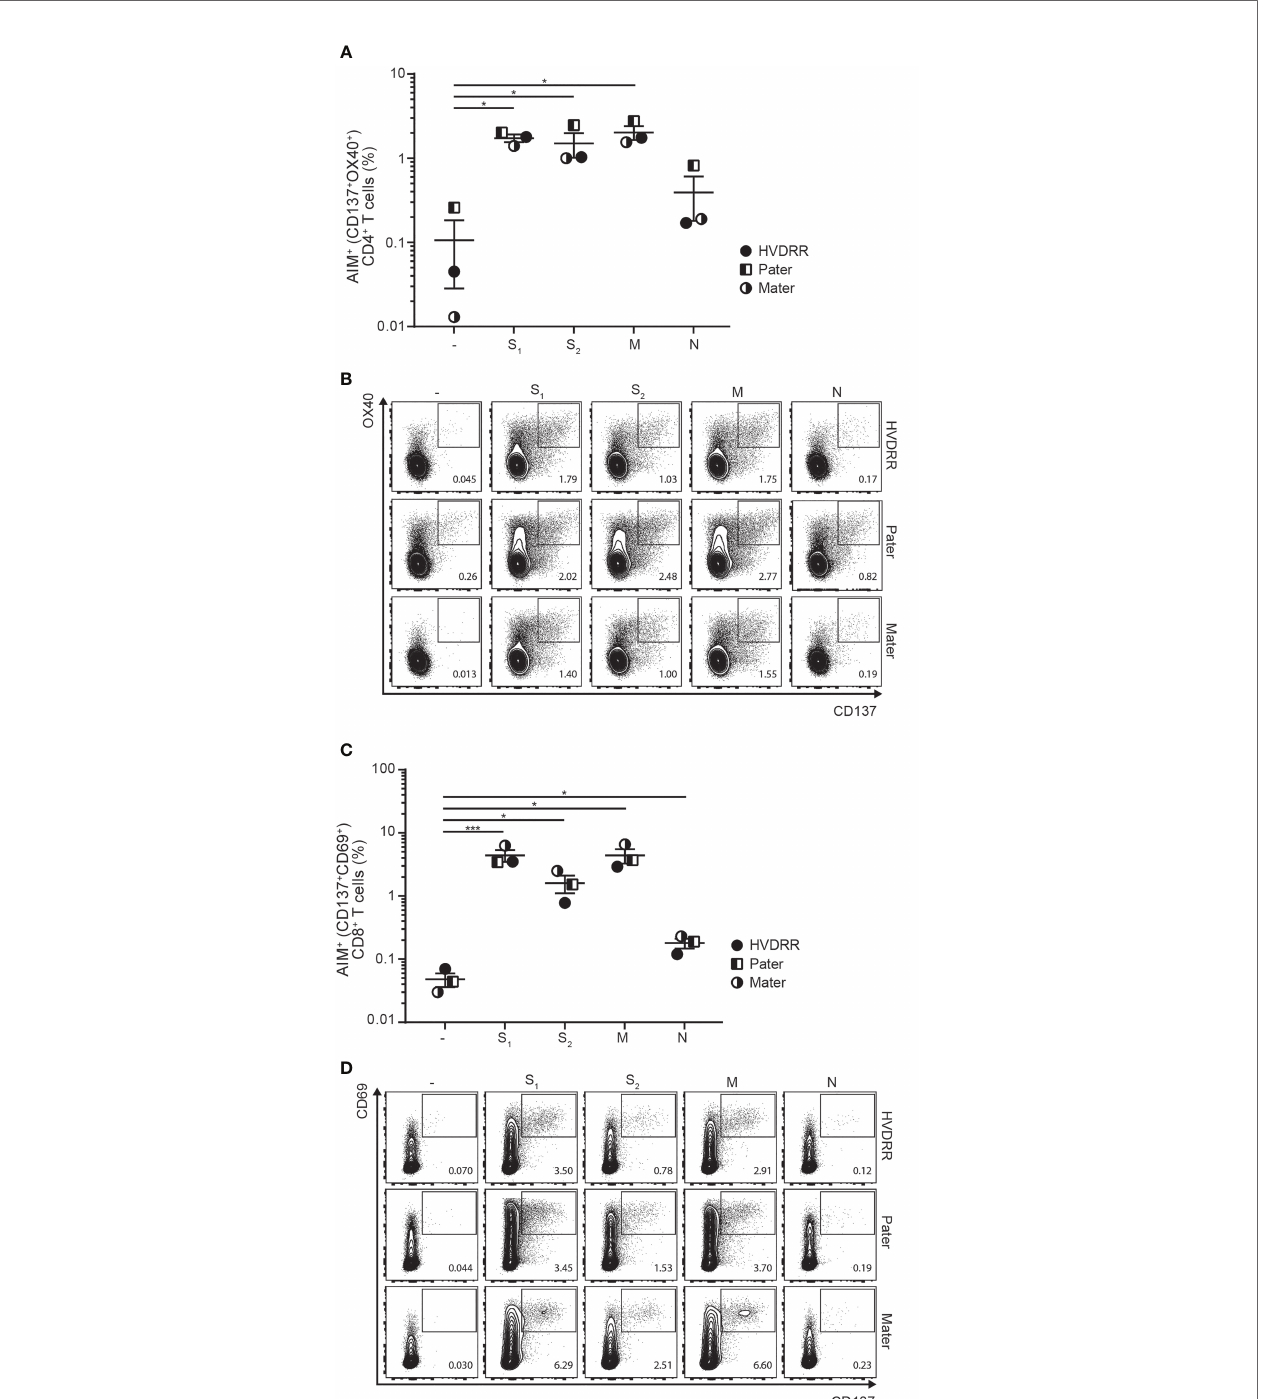
FIGURE 1 | Normal generation of SARS-CoV-2-speci fi c CD4 + and CD8 + T cells in the HVDRR patient and her parents. (A) SARS-CoV-2-speci fi c CD4 + T cells measured as percentage of AIM + (CD137 + OX40 + ) CD4 + T cells after stimulation of PBMC with peptide pools encompassing the fi rst half of the spike protein (S 1 ), the second half of the spike protein (S 2 ), the membrane protein (M) and the nucleoprotein (N). (-) represents control PBMC treated with the vehicle DMSO. Data are shown as mean ± SEM; *p < 0.05. Samples were from the HVDRR patient ( fi lled circles), pater (half- fi lled squares) and mater (half- fi lled circles). (B) FACS dot plots showing the fraction of AIM + (CD137 + OX40 + ) CD4 + T cells. (C) SARS-CoV-2-speci fi c CD8 + T cells measured as percentage of AIM + (CD137 + CD69 + ) CD8 + T cells after stimulation of PBMC with peptide pools as described in (A) . Data are shown as mean ± SEM. *p < 0.05; ***p < 0.005. Symbols indicate the individuals as described in (A) . (D) FACS dot plots shoving the fraction AIM + (CD137 + CD69 + ) CD8 + T